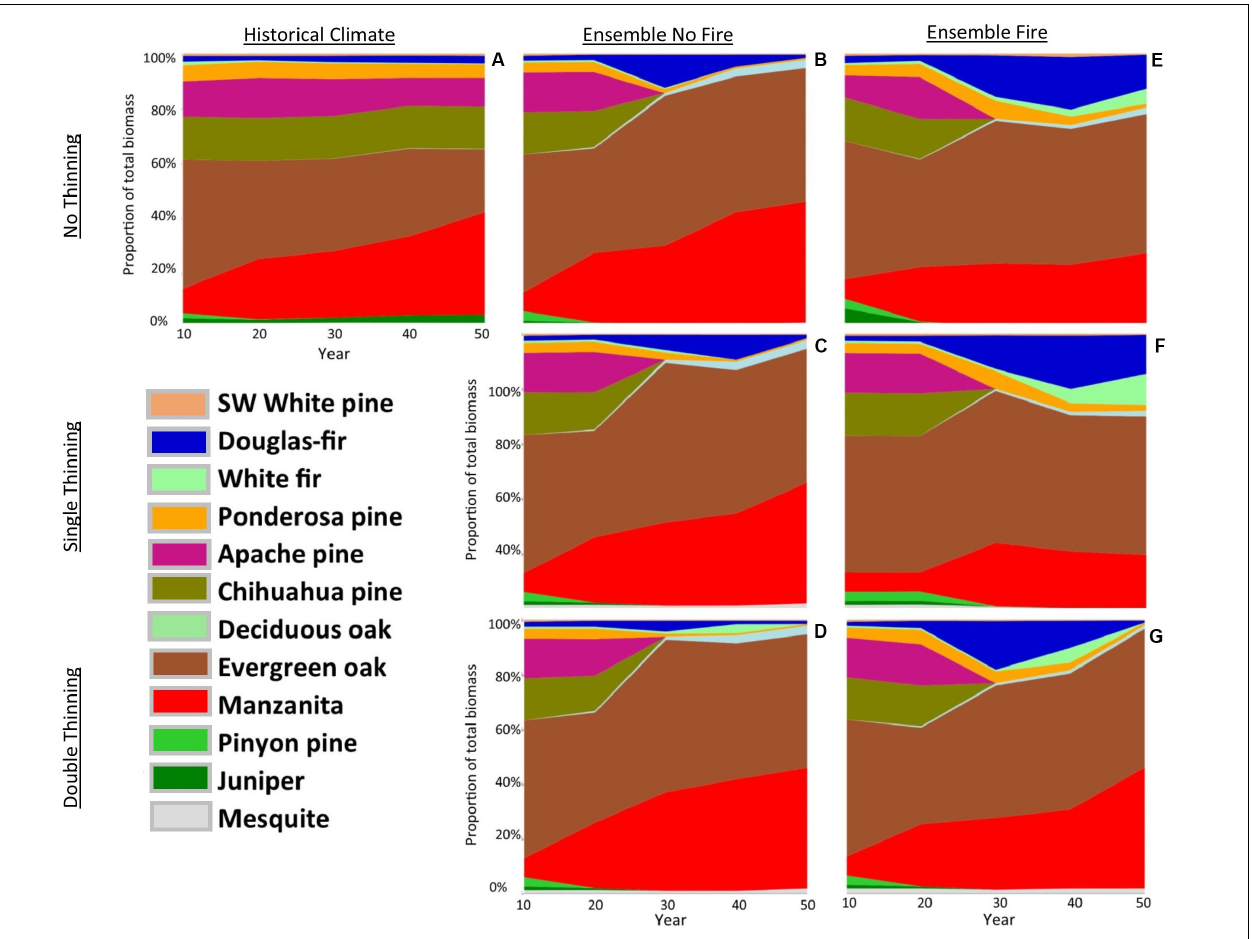
FIGURE 6 | Species dynamics (relative abundance) over a 50-year time series with varying climate, disturbance, and management actions. Historical climate with fire (A) is used as a baseline for comparison to projected climate ensemble without fire and (B) no fuel treatments, (C) single-entry thinning, and (D) double-entry thinning as well as projected climate with fire and (E) no fuel treatments, (F) single-entry thinning, and (G) double-entry